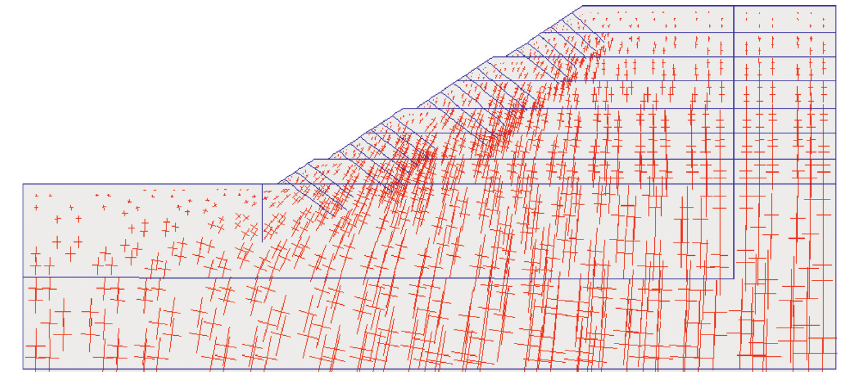
Figure 3: The effective stress distribution when the slope construction conditions are finished.